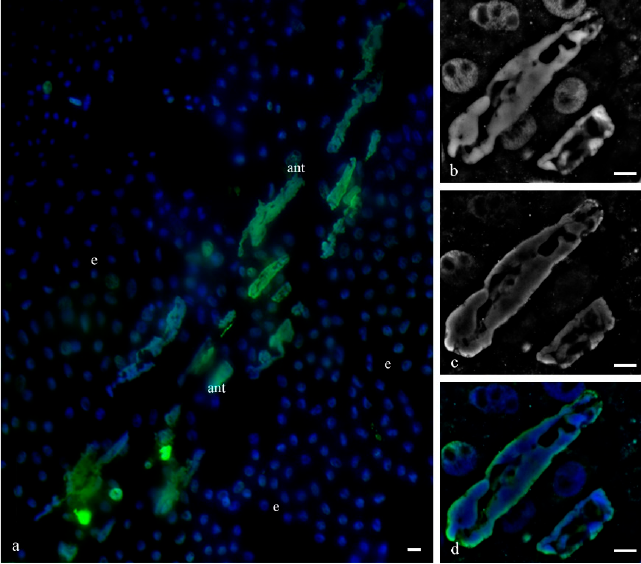
Figure 14. DNA breaks in the nuclei of the wheat antipodal cells detected by the TUNEL assay at various stages of PCD. Breaks were not detected in all cells of the antipodal complex ( a ), and most of the breaks were detected in DNA at the periphery of the nucleus ( b – d ) or were detected in the entire volume of the chromosomes ( a ). ant—antipodal nuclei, e—endosperm nuclei. The scale is 10 µm.